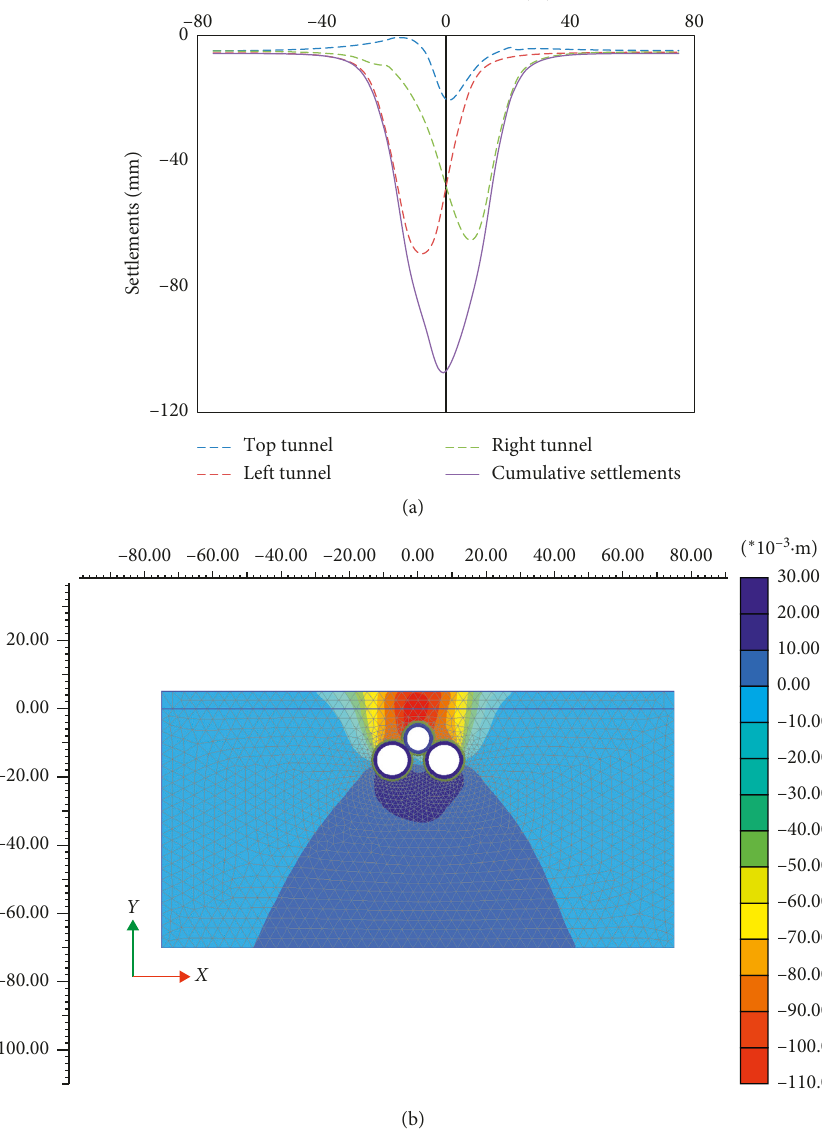
Figure 10: (a) Settlement trough of Left-Right-Top tunnel sequence. (b) Displacement contours resulting from Left-Right-Top